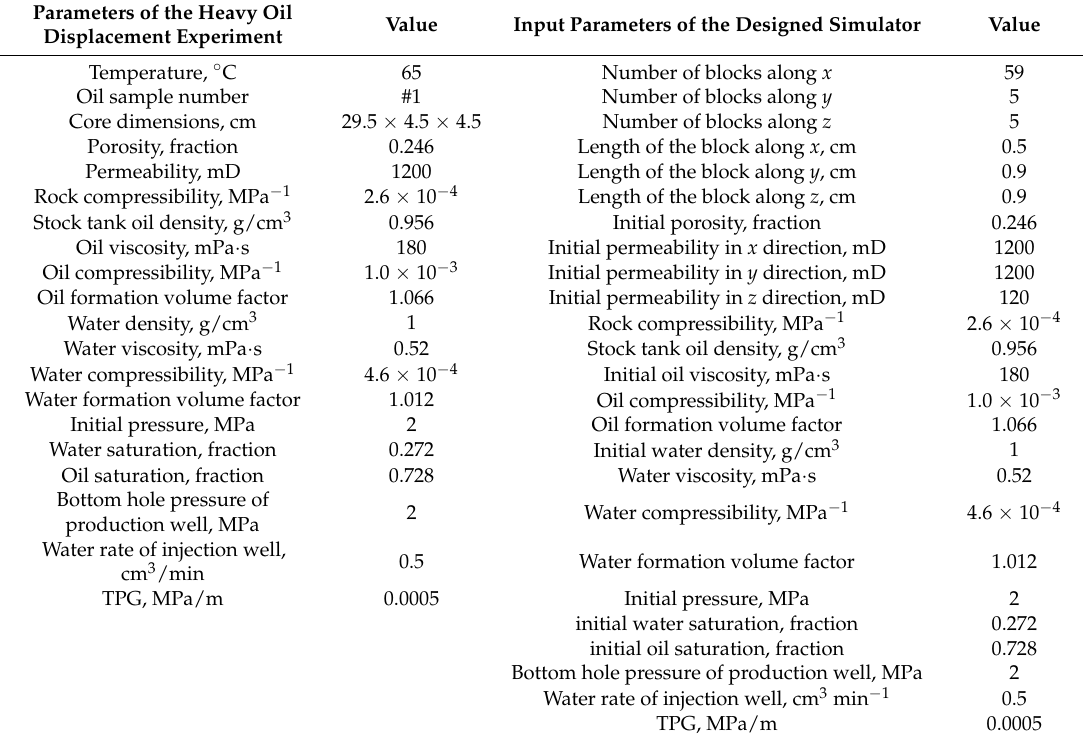
Table 9. Main Parameters of heavy oil displacement experiment and numerical simulation.